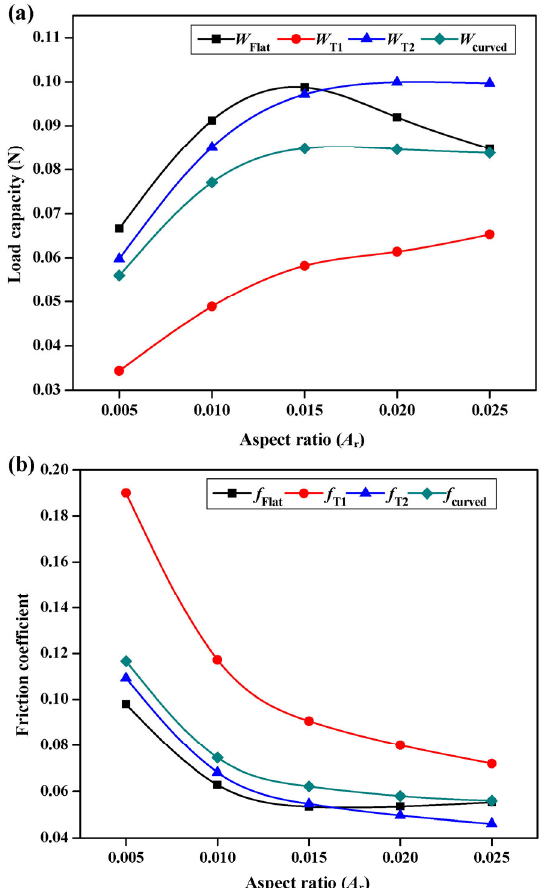
Fig. 8 Effect of texture density on (a) load capacity and (b) friction